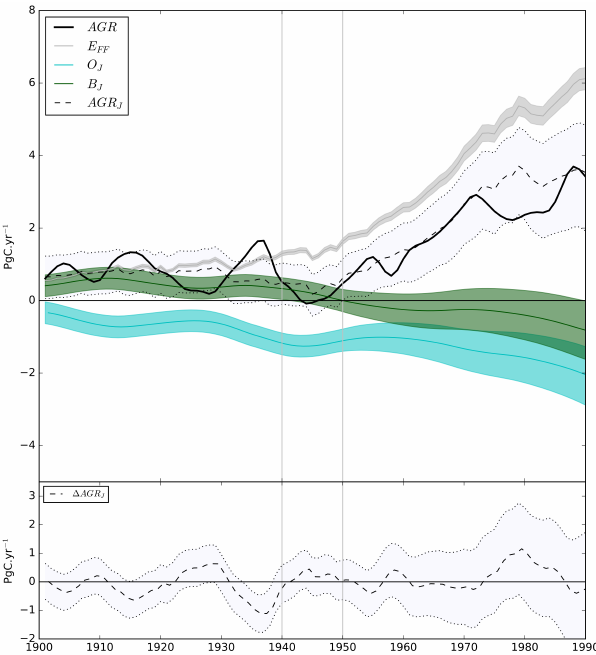
Figure 2. Atmospheric CO 2 growth rate (AGR) from the observa- tional record, calculated from the spline fit in Fig. 1 (black line, top panel). Fossil-fuel emissions from the CDIAC database and re- spective uncertainty ( E FF ) and the reconstruction of ocean ( O J ) and biospheric ( B J ) fluxes from Joos et al. (1999) (filled areas in top panel). The resulting balance from the latter three datasets (AGR J ) and uncertainty is shown in the top panel (dashed and dotted lines, respectively), and the corresponding difference between AGR and AGR J is shown in the bottom